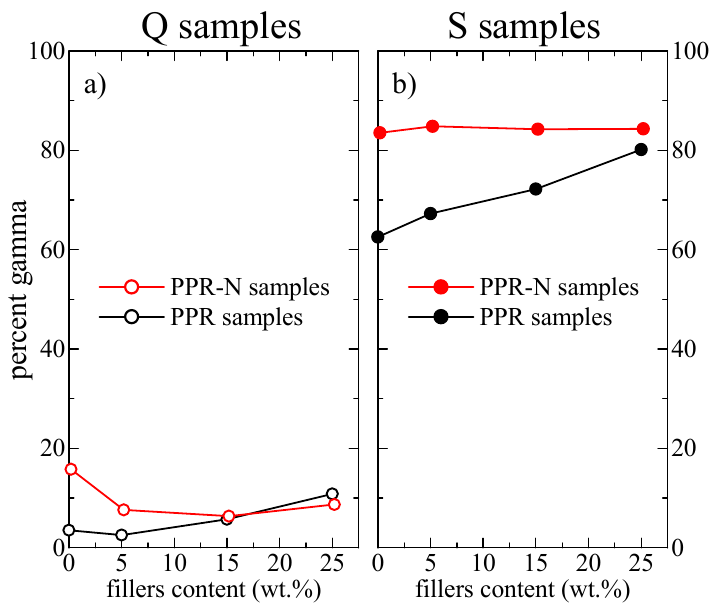
Figure 3. Variations in the percentages of γ modifications as functions of the filler content (DSF and Millad nucleant): ( a ) Q sample; ( b ) S sample.